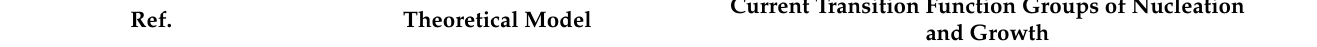
Table 1. A summary of the current–transition functions of nucleation and growth in the references.